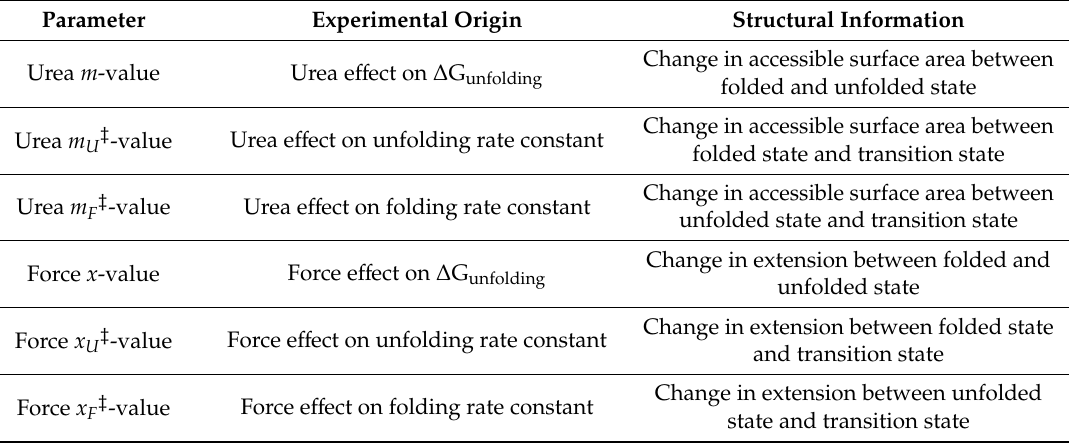
Table 1. Parameters measured in chemo-mechanical unfolding experiments and the structural information that they